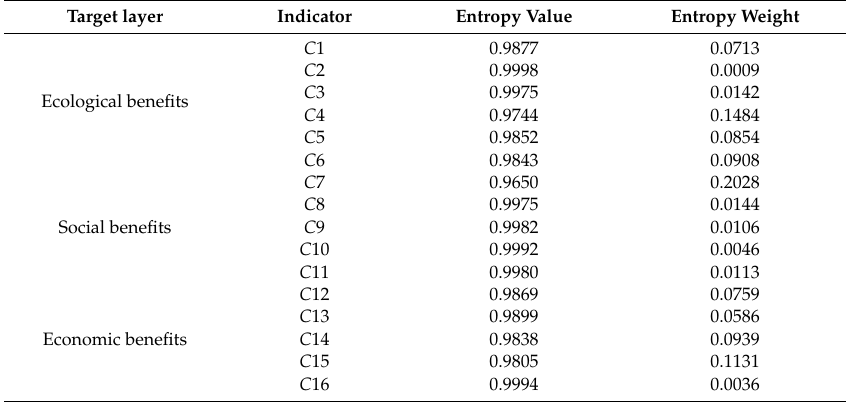
Table 3. Weights of evaluation indicators for the water environment integrated